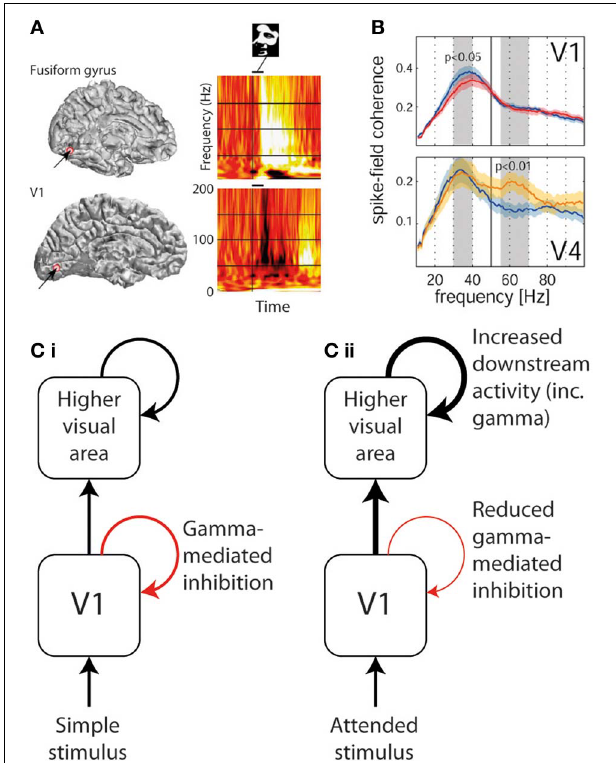
FIGURE 3 | Divergent trends in gamma oscillation responses in different areas of visual cortex. (A) Gamma response to a face stimulus in V1 (lower—showing predominantly narrowband gamma power decrease) and in fusiform gyrus (upper—showing broadband gamma power increase) in the same human patient (reproduced with copyright-holder’s permission from Lachaux et al., 2005). (B) The effect of selective attention (blue plot = unattended, red/yellow = attended) on gamma power in V1 (upper—showing narrowband gamma decrease) and in V4 (lower—showing gamma increase in a higher broader frequency band; reproduced with copyright-holder’s permission from Chalk et al., 2010). (C) Schematic of how above findings can be reconciled if narrowband gamma oscillations are considered an inhibitory process. (i) In response to most basic passively-viewed stimuli, inhibitory narrowband gamma occurs in V1, but onward activity is still conveyed to higher visual areas also triggering gamma oscillations. (ii) In response to explicitly or implicitly attended stimuli, inhibitory narrowband gamma oscillations are reduced, leading to increased onward activity being conveyed to higher visual areas, which in turn triggers stronger gamma